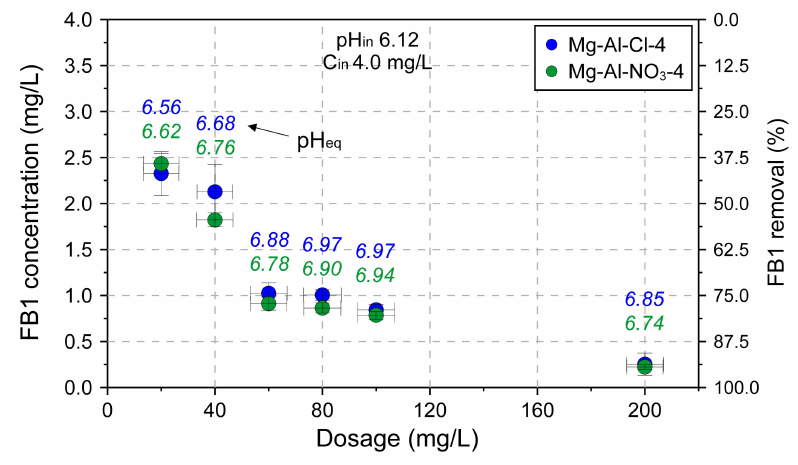
Figure 8. The dosage e ff ect on adsorption capacity of selected LDH